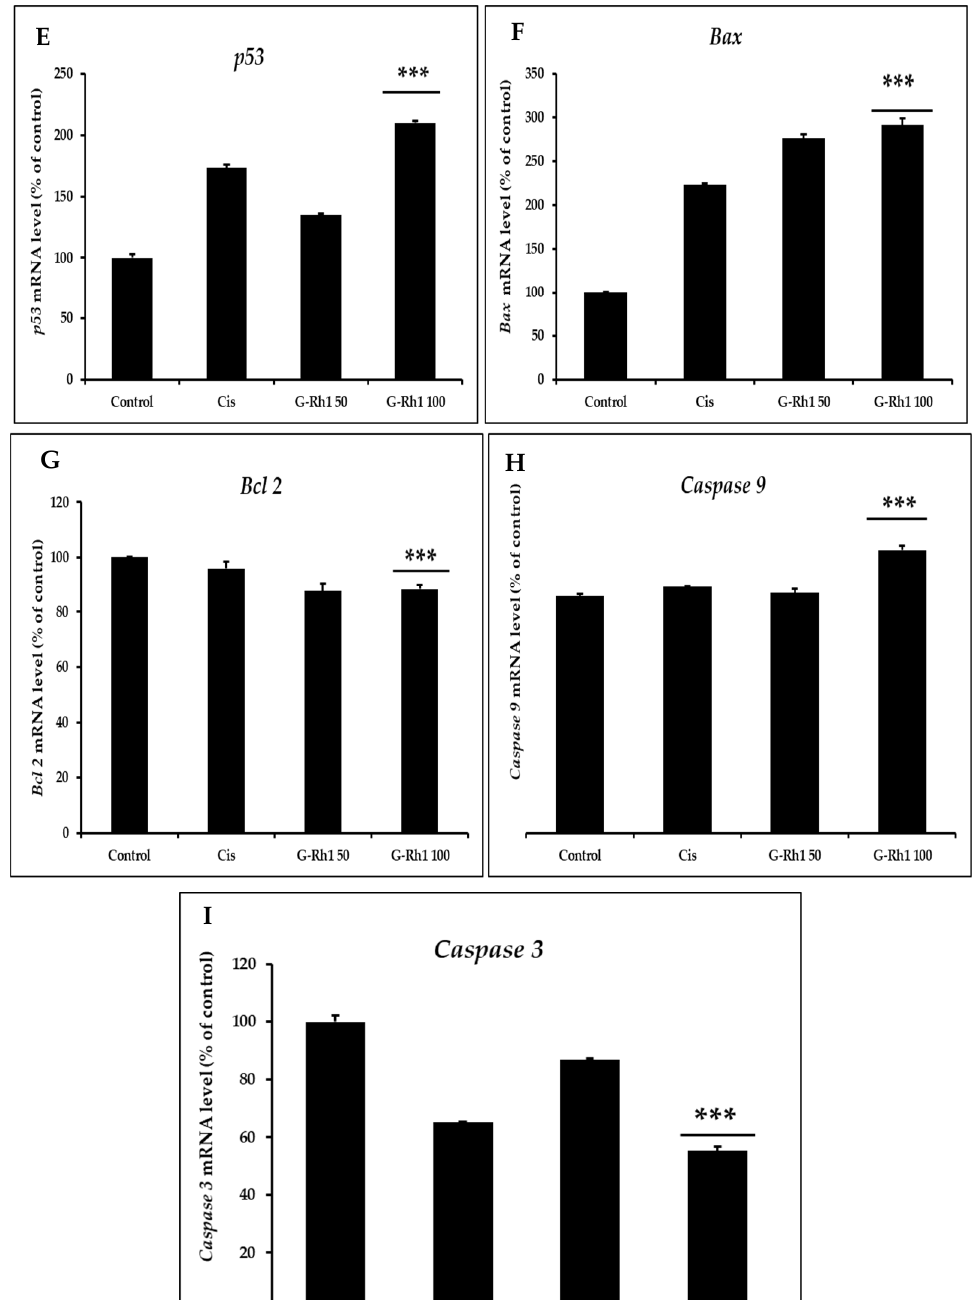
Figure 11. Effects of G-Rh1 on mRNA expression levels of apoptosis-related genes in A549 cells. Here, A549 cells were treated with G-Rh1 at 50 and 100 µg/mL for 24 hr. Subsequently, total RNAs were extracted, and the mRNA expression levels were determined by RT-PCR analysis with different apoptotic genes including ( A ) ROCK, ( B ) RhoA, ( C ) MMP-1, ( D ) MMP- 9, ( E ) p53, ( F ) Bax, ( G ) Bcl2, ( H ) Caspase 9, ( I ) Caspase 3 and compared with those of GAPDH. In A549 cells, RhoA, ROCK1, MMP1, and MMP9 mRNA expression was decreased by G-Rh1. While downregulating Bcl2, G-Rh1 increased p53, Bax, Caspase 3, and Caspase 9. The data shown are representative of the mean values of three independent experiments ±SD. *** p < 0.001 as compared to the non-treated control .